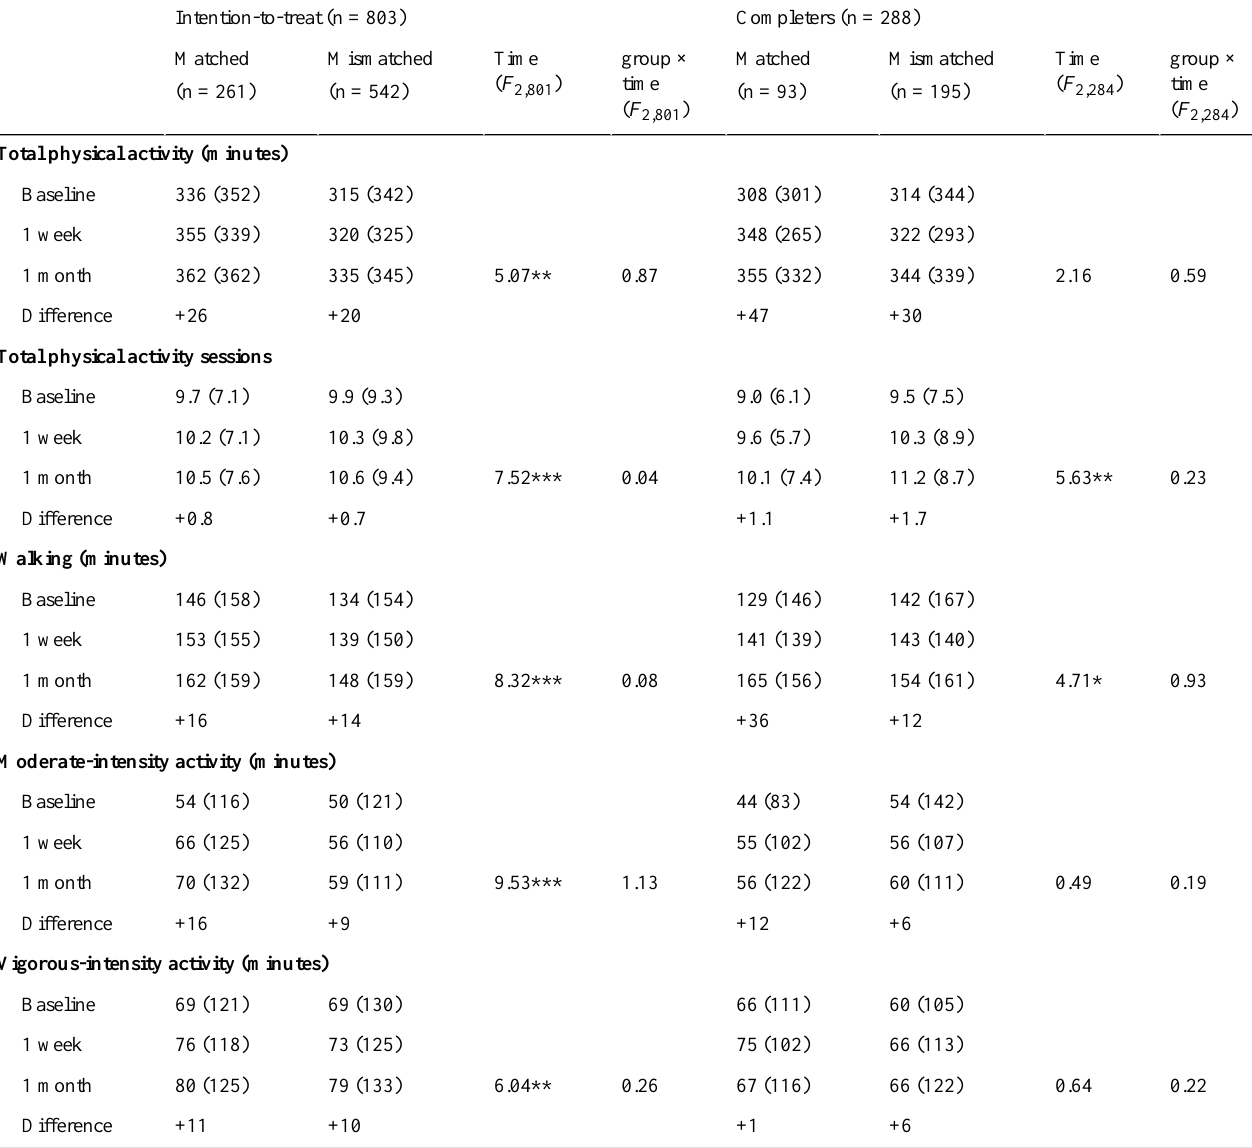
Table 3. Main and interaction effects for physical activity (mean, SD) between matched and mismatched